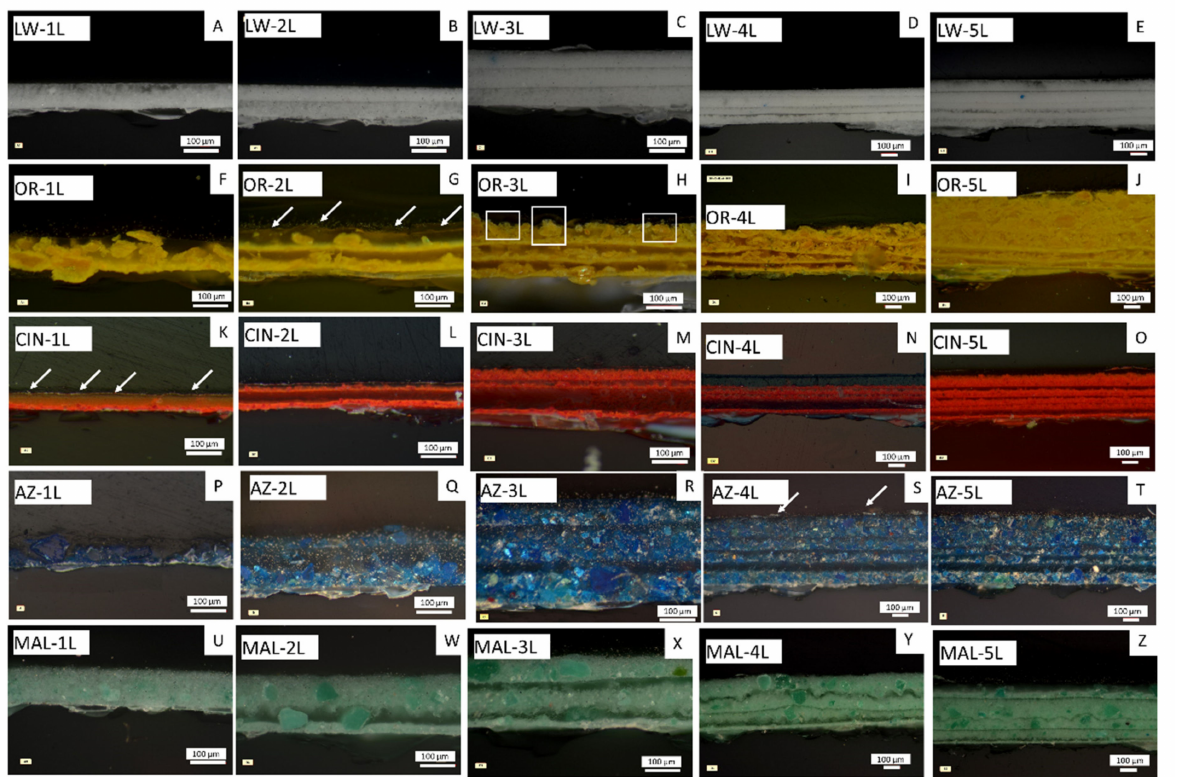
Figure 4. Cross-sections of the mock-ups under polarized light microscopy (transmitted light and cross polar modes). The samples were examined to determine the influence of the thickness of the paint layer (one layer to five layers, 1L to 5L) on the spectral reflectance. ( A – E ): lead white (LW)-based oil painting mock-ups. ( F – J ): orpiment (OR)-based oil painting mock-ups. ( K – O ): cinnabar (CIN)- based oil painting mock-ups. ( P – T ): azurite (AZ)-based oil painting mock-ups. ( U – Z ): malachite (MAL)-based oil painting mock-ups. Arrows indicate the accumulation of binder and rectangles indicate grains protruding from the